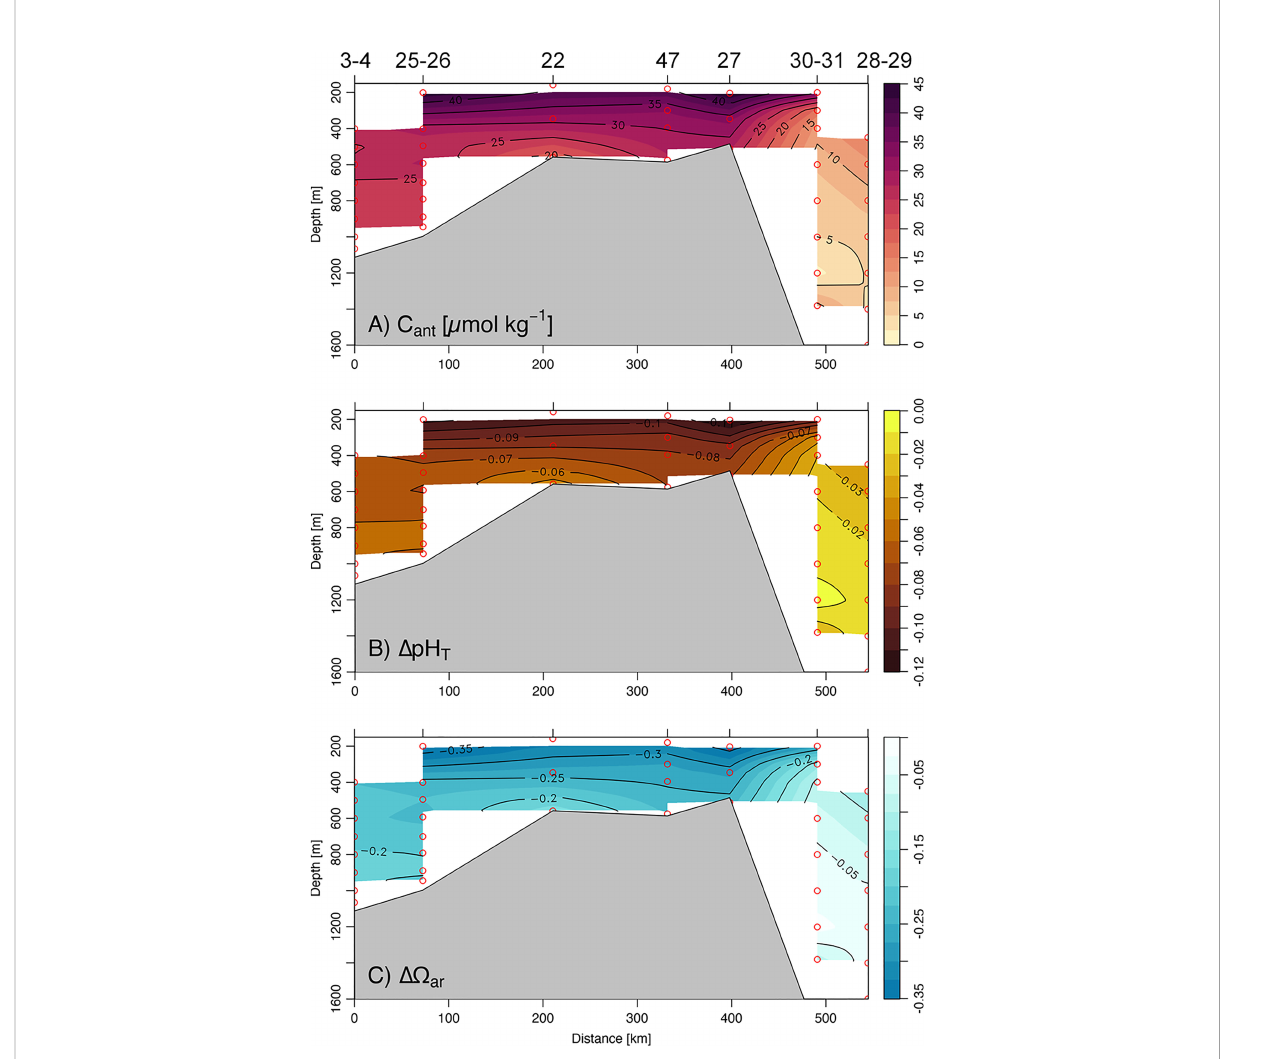
FIGURE 6 South-north vertical section across the Ross Sea (see Figure 1) for (A) anthropogenic carbon concentration ( C ant ; m mol kg − 1 ), (B) pH reduction from preindustrial time ( D pH T ), and (C) aragonite reduction from preindustrial time ( DW ar